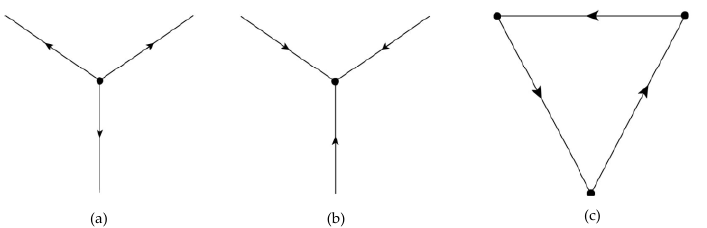
Figure 2. Suspicious topological structure in drainage network. ( a ) All-up; ( b ) ALL-down; ( c ) Cy- cle.